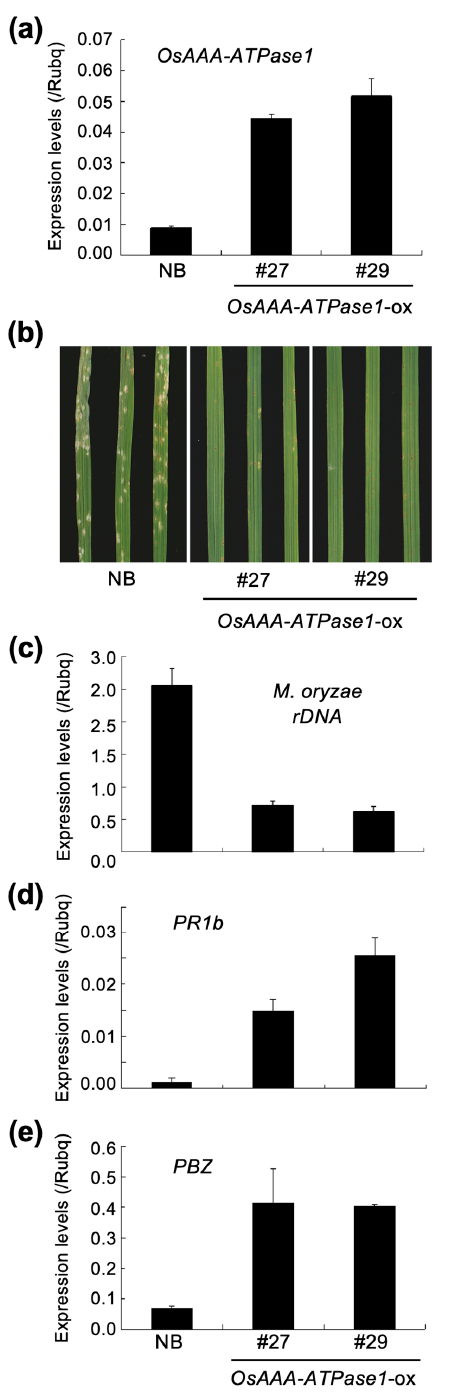
Figure 4. Blast resistance of OsAAA-ATPase1 -ox plants. ( a ) Expression of OsAAA-ATPase1 , ( b ) blast lesions on leaf blades, and ( c ) relative fungal growth ( Magnaporthe oryzae rDNA ). ( d , e ) Expression of PR1b ( d ) and PBZ1 ( e ), in Nipponbare (NB) and OsAAA-ATPase1 -ox lines (#27 and #29), respectively, at 7 days post inoculation (dpi). Data are represented as means ± SDs in ( a , c – e